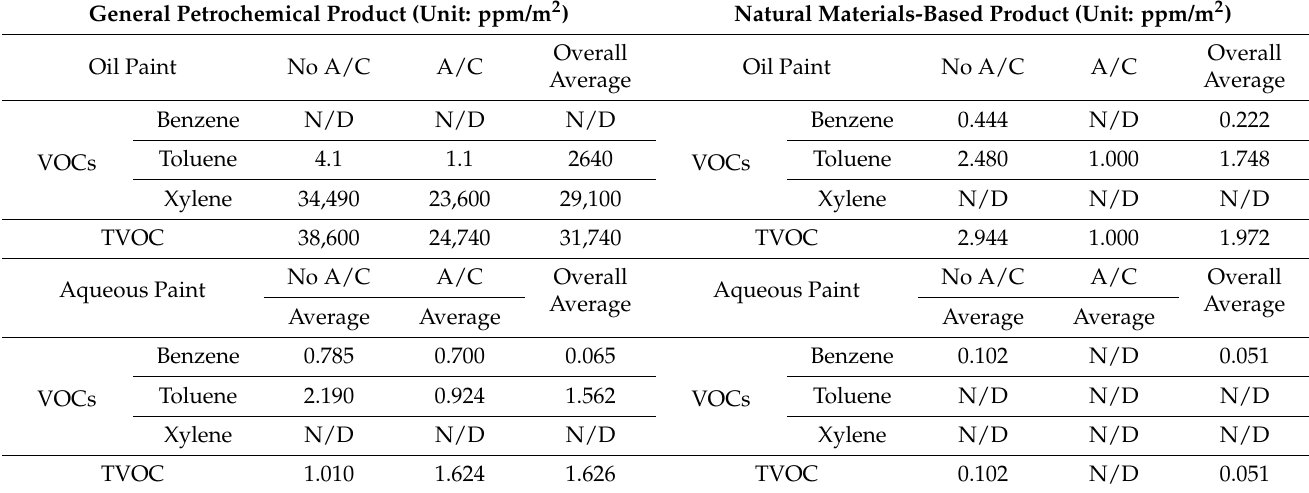
Table 4. Laboratory measurement results of emission of VOCs in